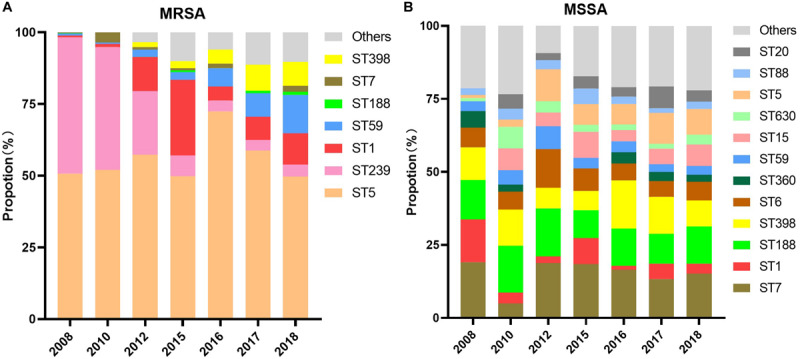
Composition of clones of (A) MRSA and (B) MSSA, 2008–2018.